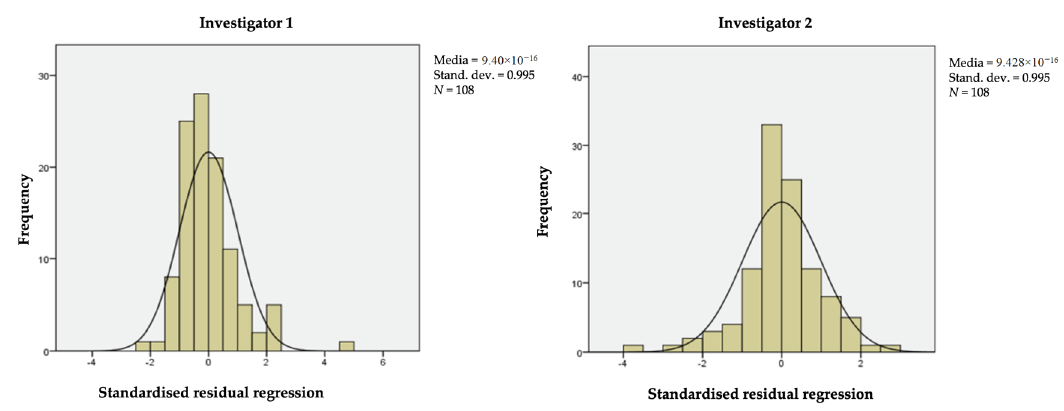
Figure 2. Standardized residual regression of data obtained in the investigations.